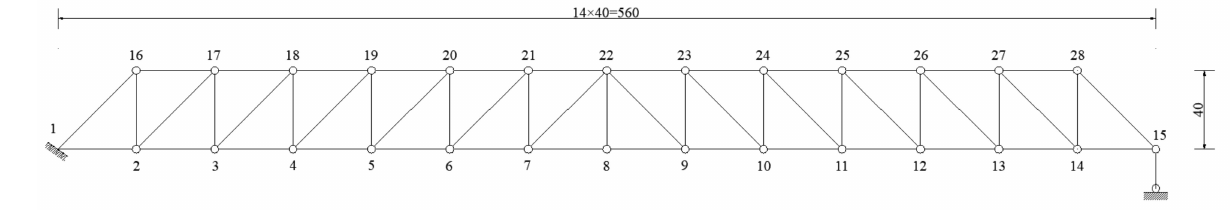
Figure 2. The diagram of plan truss (Unit: